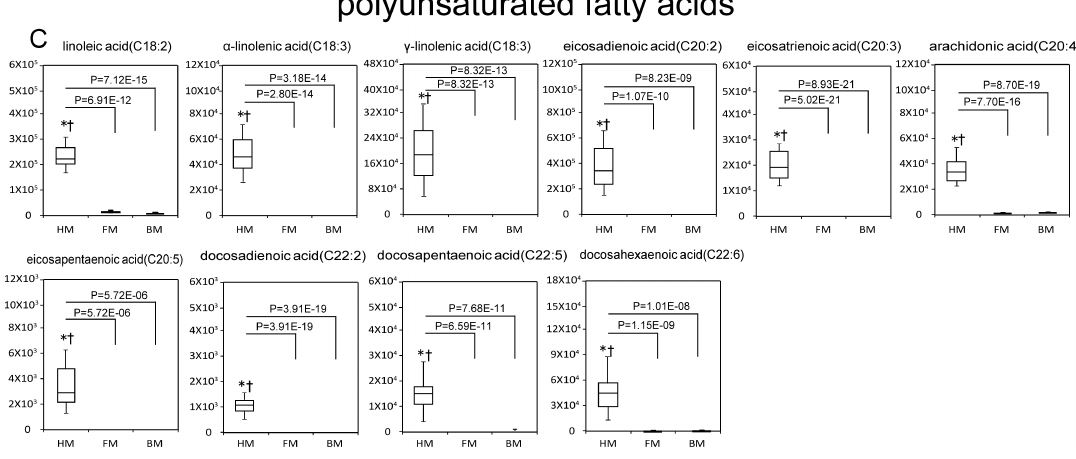
Figure 3. Comparison of the relative abundances of saturated fatty acids ( A ), monounsaturated fatty acids ( B ) and polyunsaturated fatty acids ( C ) among HM, FM and BM. The Y-axis represents the normalized peak area. Boxes contain the 25%–75% measurements for each group, and whiskers cover the 5%–95% measurements. The horizontal lines within the box represent the median values. * p < 0.05 vs. FM; † p < 0.05 vs. BM. Kruskal–Wallis H test followed by Bonferroni-corrected post-hoc